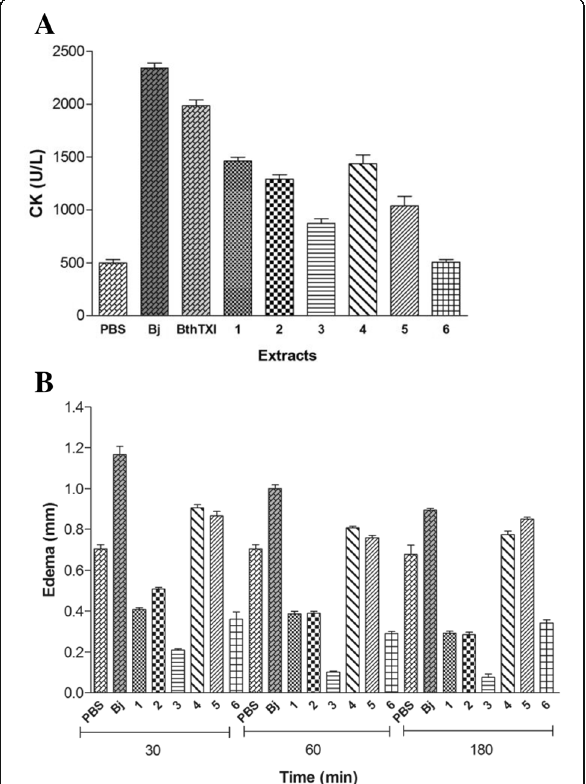
Fig. 6 Myotoxic activity and edema-induction by cnidarian extracts . (Bj) B. jararacussu snake venom and (BthTX-I) Bothropstoxin-I from B. jararacussu (1) C. gigantea (body-wall), (2) C. gigantea (total), (3) M. alcicornis, (4) S. helianthus (5) P. homomalla , (6) B. annulata. ( a ) CK activity was measured 3 h after the i.m injection of 50 μ L with 50 μ g of each cnidarian extracts (1 – 6) and 20 μ g of the Bj and BthTX-I. Results are presented as means ± S.D. ( n = 4). ( b ) Paw edema in Swiss mice was induced by injection of 100 μ g of cnidarian extracts and 10 μ g of Bj at 30, 60 and 180 min. Results are reported as mean % ± S. D ( n = 6)